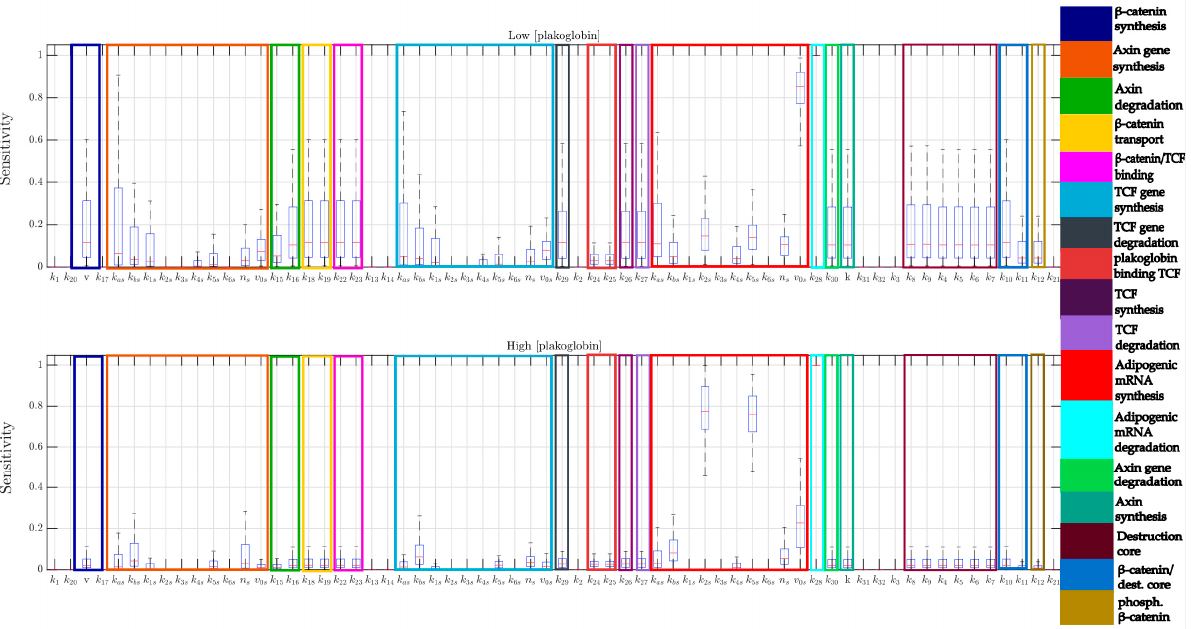
Figure 2. Overview of the Multi-parametric Sensitivity Analysis (MPSA) on Adipogenic mRNA for all the parameters of the WPC extended model. MPSA was performed at low (top panel) and high (bottom panel) initial concentrations of PG. The legend on the right refers to the parameters involved in each specific reaction.